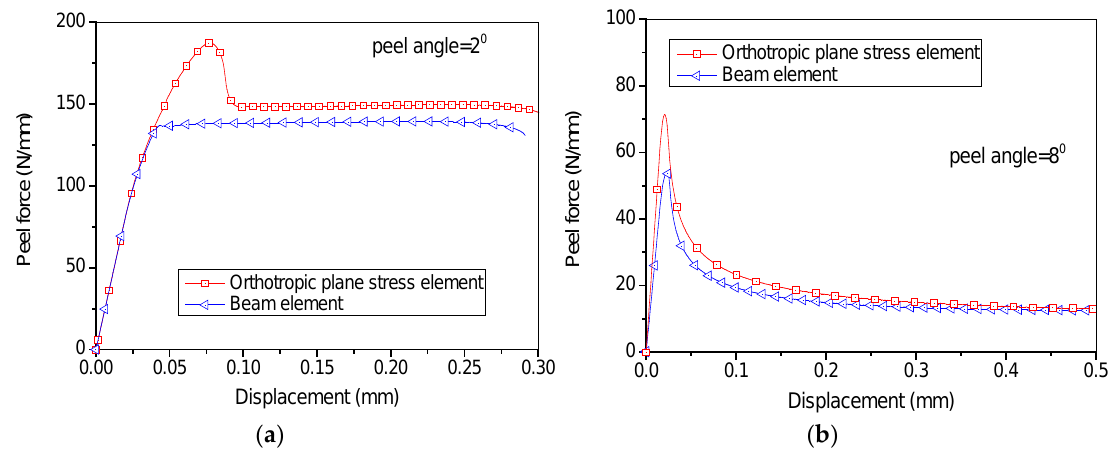
Figure 6. Influence of different element types on the load-displacement curves (1 layer of dry fiber sheets): ( a ) Peel angle = 2 degree; ( b ) Peel angle = 8 degree.